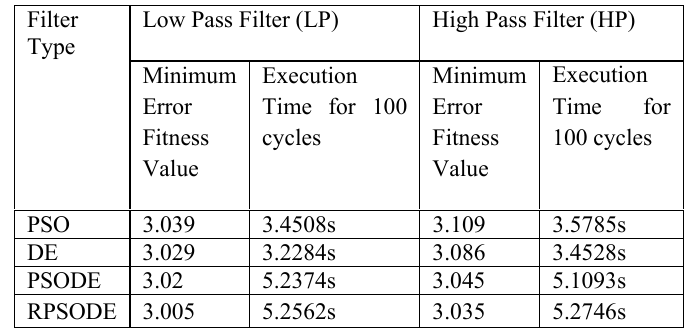
Table 6.Comparison of minimum error fitness value and